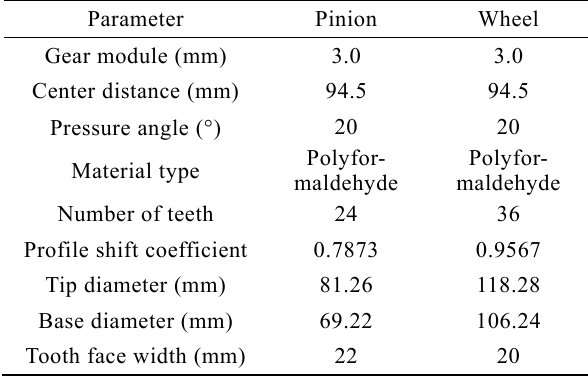
Fig. 1 Polyformaldehyde gear samples. Table 1 Basic parameters of the tested gear